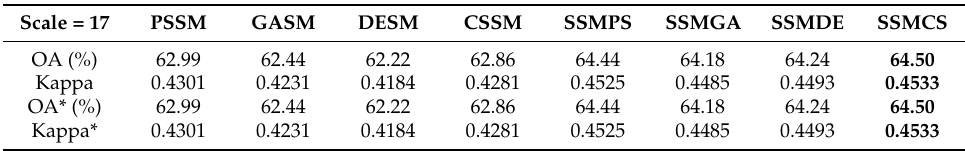
Table 5. Comparison of the sub-pixel mapping algorithm performances for the Landsat TM image in Experiment 3.